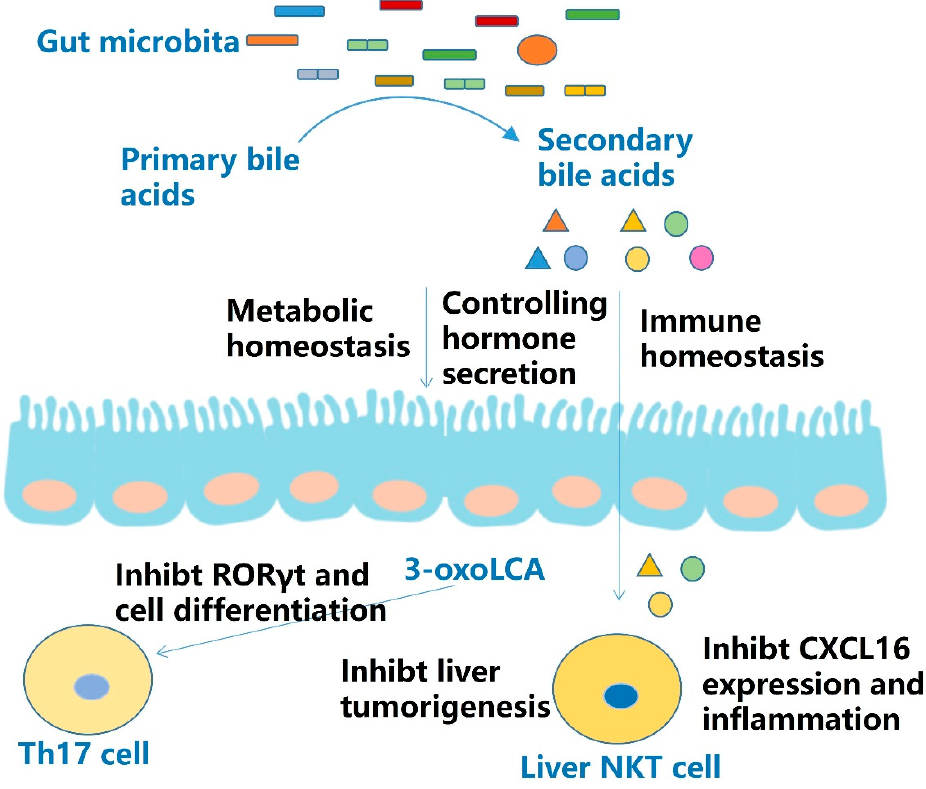
Figure 5. Effect and mechanism of secondary bile acids.